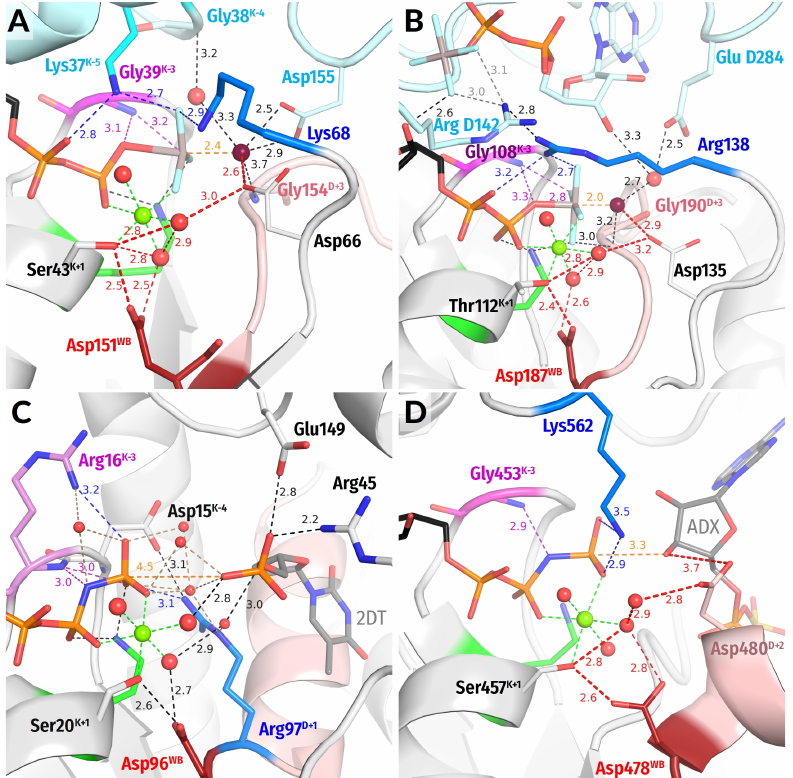
Figure 4. Representatives of the SIMIBI and kinase classes. The Arg and Lys residues belonging to the same protein chain as the Walker A motif, i.e., to the lid domains in kinases, are shown in blue. Red dashed lines mark protonic connections between W cat and Asp WB . Other colours as in Figures 1E,F and 3. All distances are indicated in ångströms. ( A ) ATP-binding component of the dark- operative protochlorophyllide reductase (PDB ID 2YNM, [97]). ( B ) The signal recognition particle (FtsY/Ffh) complex (PDB ID 2CNW, [98]). ( C ) Human thymidylate kinase (PDB ID 1NN5 [99]). ( D ) Adenosine 5 (cid:48) -phosphosulfate kinase (PDB ID 4BZX,